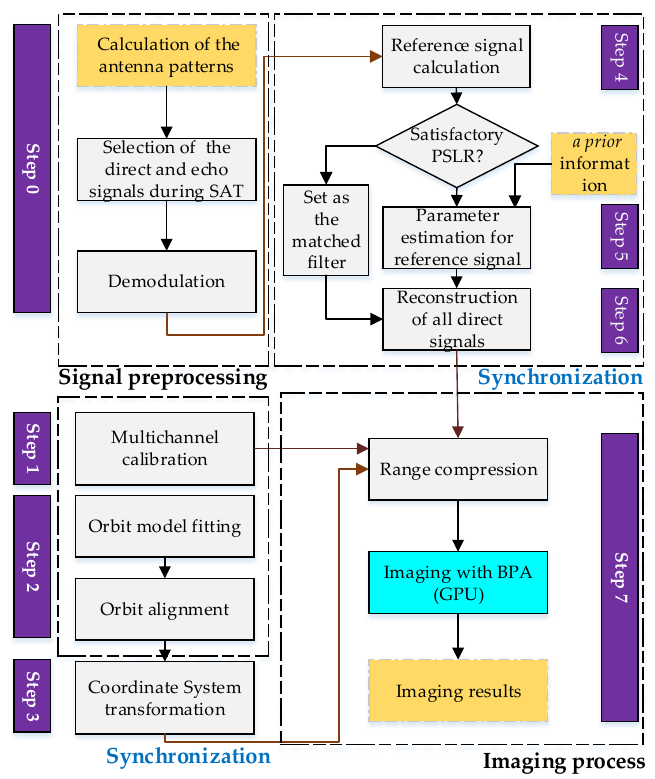
Figure 5. The BiSAR processing